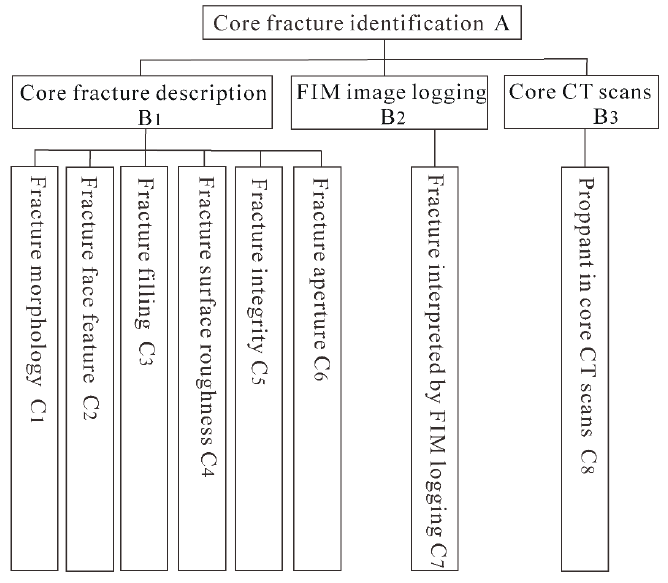
Figure 9. Hierarchical structure model of core fracture identification.